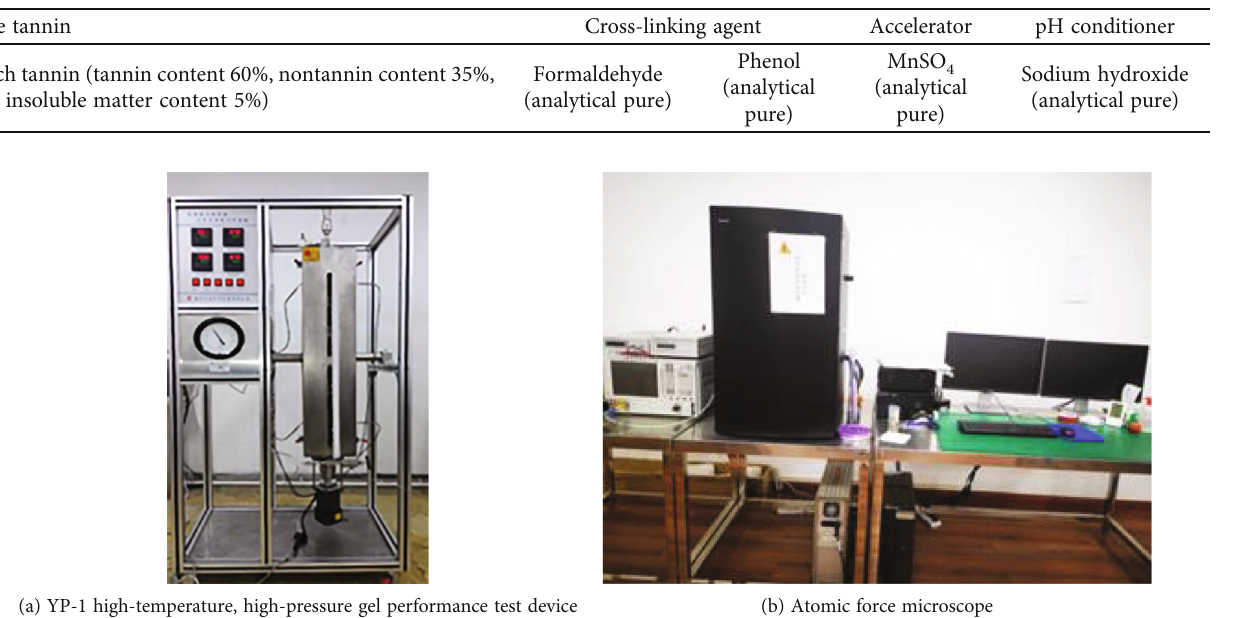
Table 2: Experiment reagents used in this study.